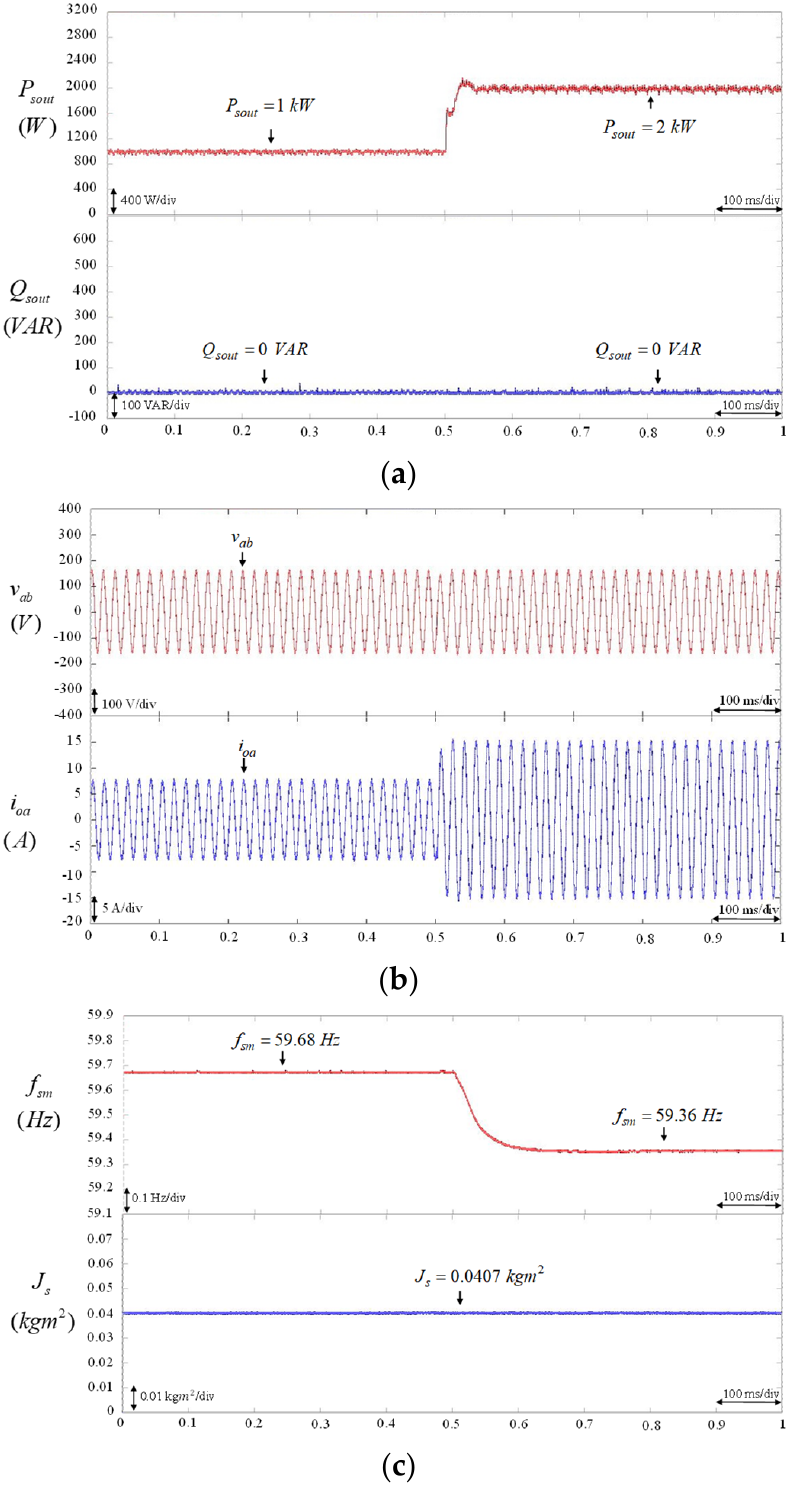
2 kgm . ( a ) Responses